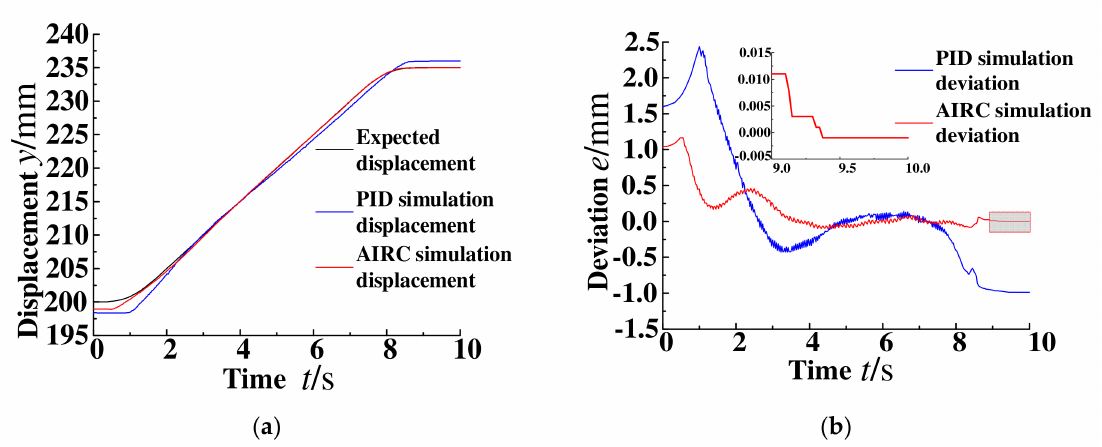
Figure 12. System displacement and deviation curve under working condition 2 (cid:13) . ( a ) System displacement curve. ( b ) System displacement deviation curve.